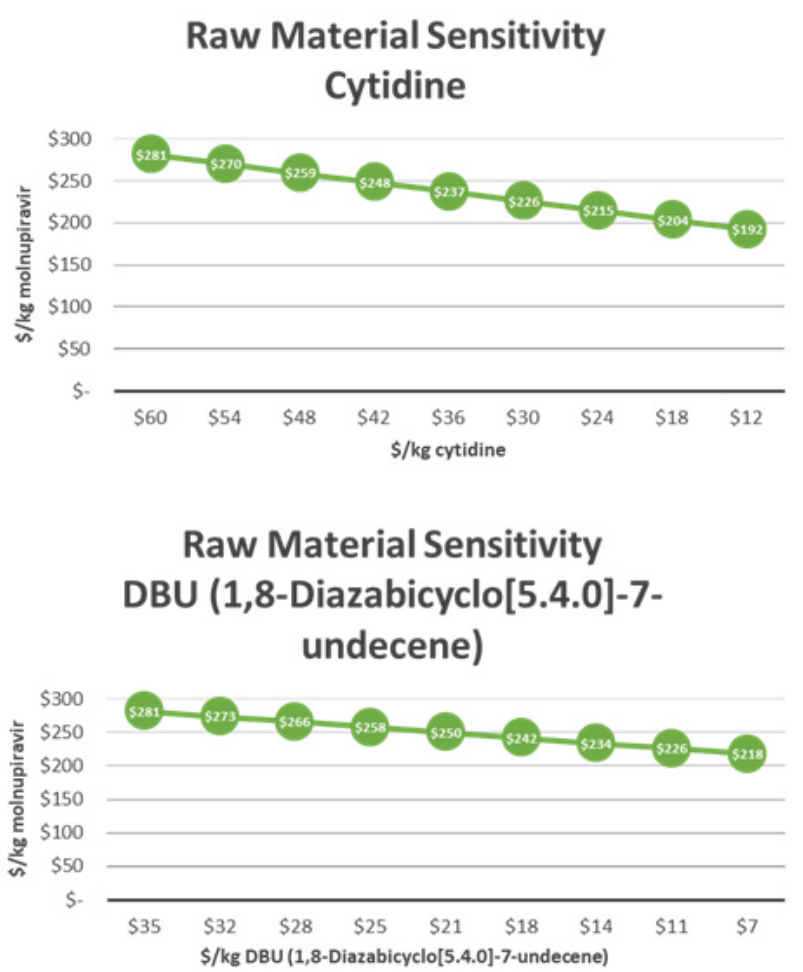
Figure 4. M4ALL Chemical Route from Cytidine sensitivity analysis for (a) cytidine and (b) 1,8-Diazabicyclo[5.4.0]-7-undecene.